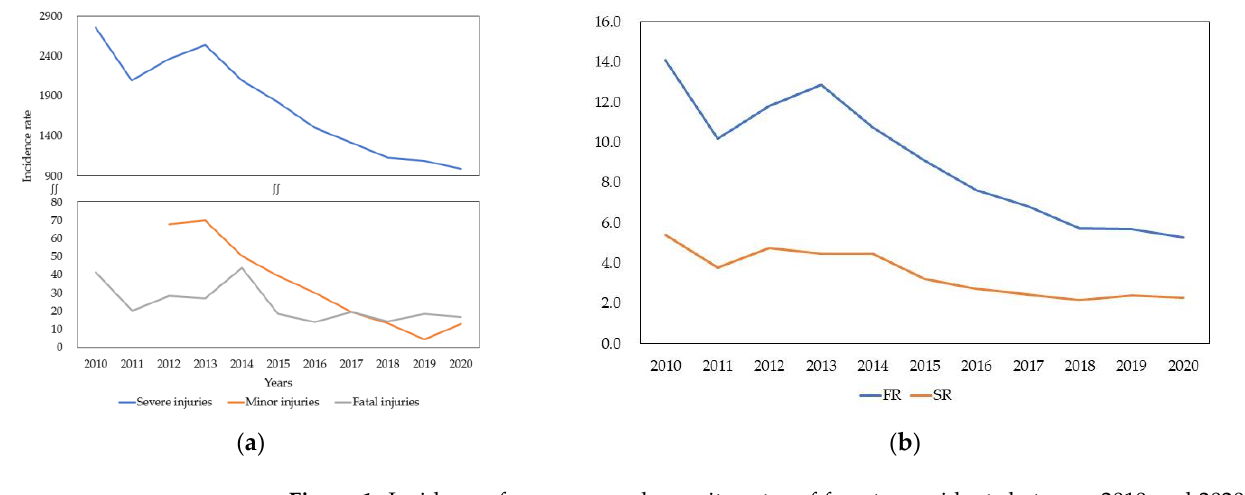
Figure 1. Incidence, frequency, and severity rates of forestry accidents between 2010 and 2020 in Korea: ( a ) incidence rate, and ( b ) frequency rate (FR) and severity rate (SR).